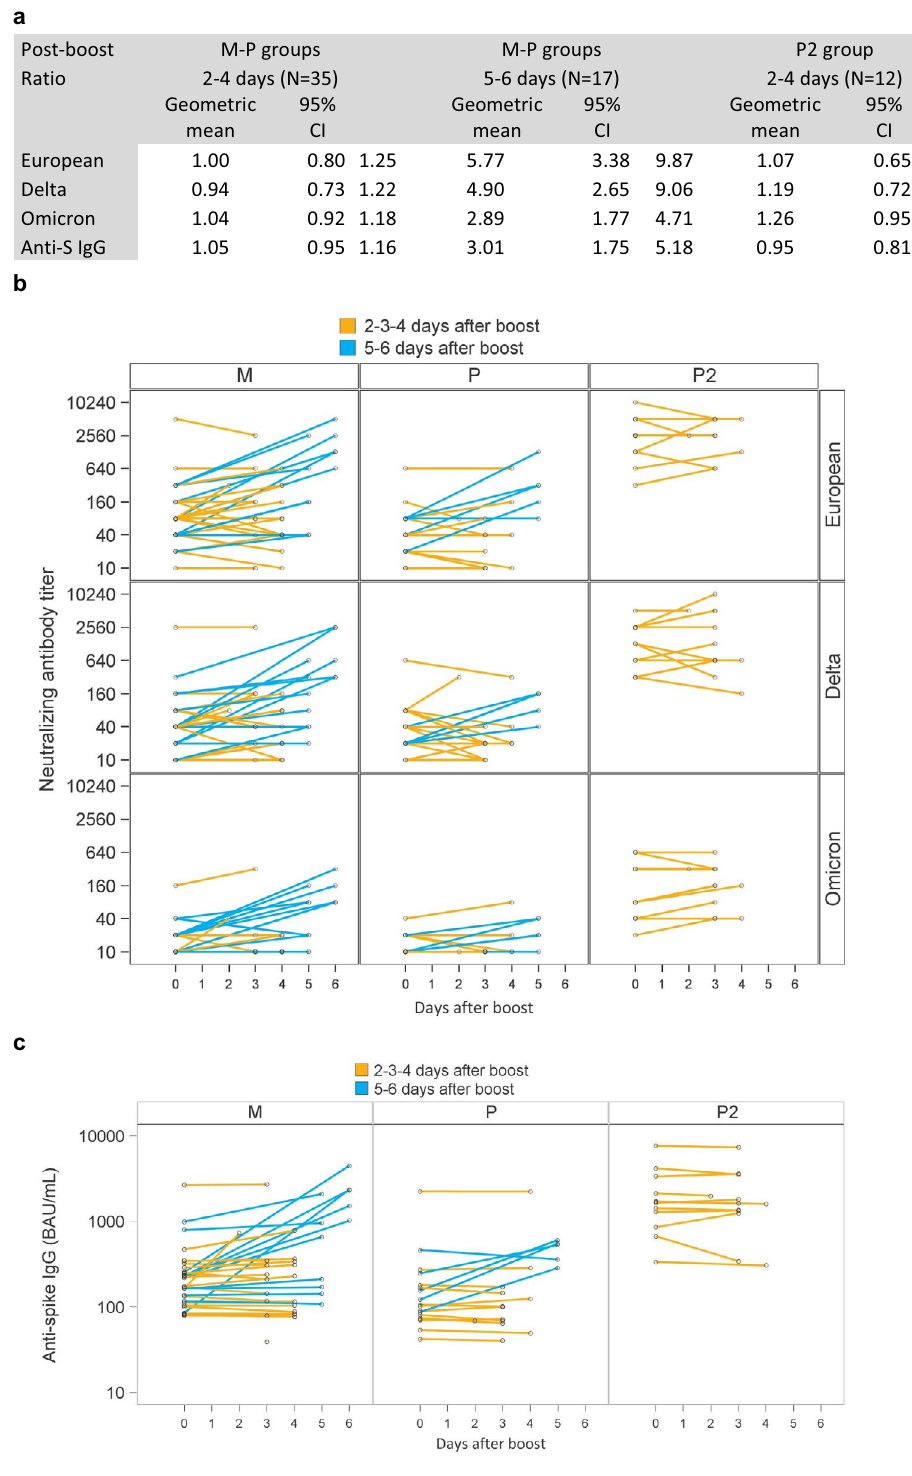
Figure 2. Focus on early antibodies up to day 6 after boost in SARS-CoV-2 naïve mRNA-1273 recipients (M), BNT162b2 recipients (P) and previously SARS-CoV-2 infected BNT162b2 recipients (P2). ( a ) Post boost/pre- boost ratios (geometric means and 95% confidence intervals) ( b ) Neutralizing antibody titers for European strain, Delta, Omicron (BA.1) variants and ( c ) anti-spike IgG (BAU/mL). N = 64/65 (one participant from group M missing pre-boost